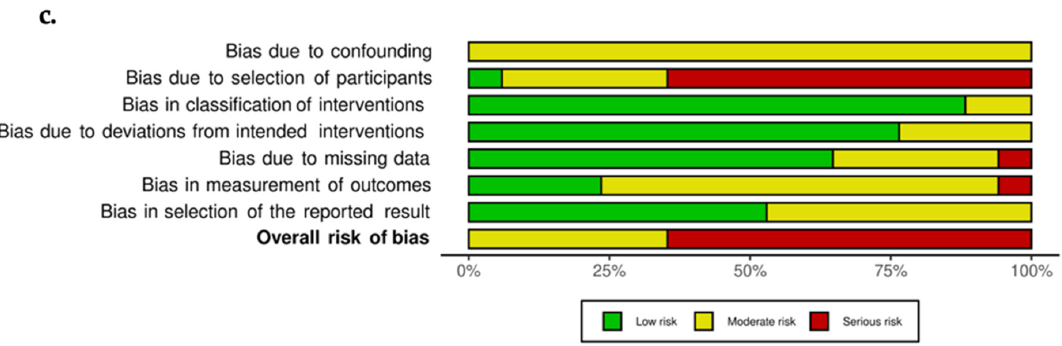
Figure 2. Quality assessment of the included studies in meta-analysis according to RoB2 [43] ( a ) and ROBINS-I [21,23,25,29–31,34,38,39,44,46–48,50,52,54,106] ( b ) tools: “traffic light” plots of the domain-level judgments for each individual result ( a , b ); weighted bar plots of the distribution of risk-of-bias judgments within each bias domain ( c ).